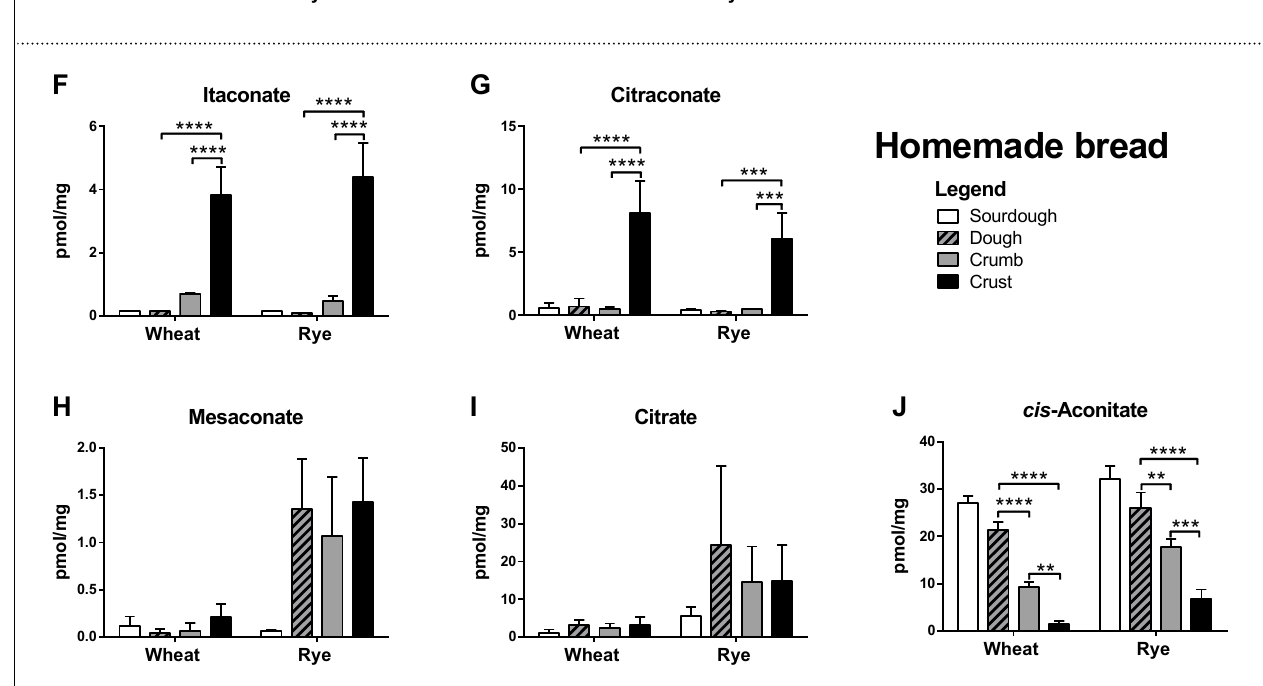
Figure 2. Comparison of analyte concentrations (pmol/mg dry weight) in crumb and crust of commercial wheat and rye bread ( A – E ) and in sourdough, dough, crumb and crust of homemade whole-grain wheat and rye bread ( F – J ). The data are a pool of three independent experiments, each comprising 3 non-technical replicates (individual sample aliquots) per sample, i.e., 9 data points per bar. Two-way ANOVA with Tukey test for multiple testing. * p ≤ 0.05, ** p ≤ 0.01, *** p ≤ 0.001, **** p ≤ 0.0001.